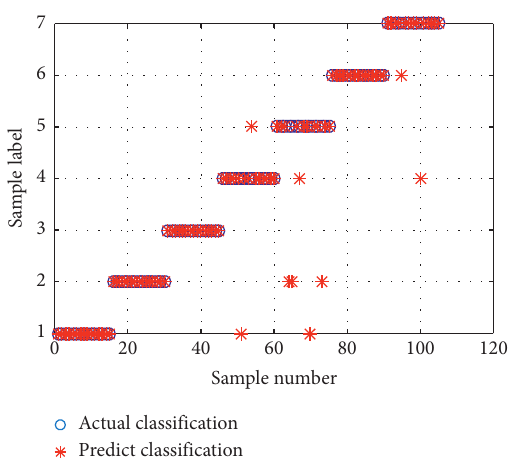
Figure 11: Classification results of EWT-SVM.